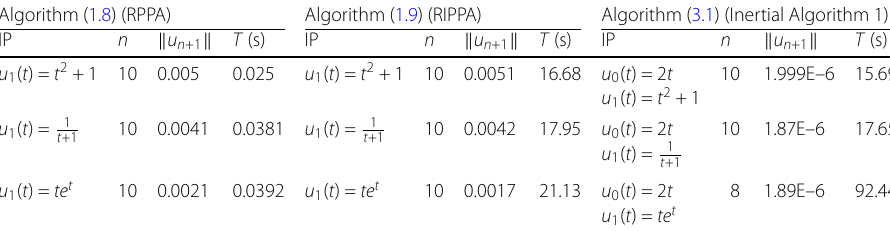
Table 2 Numerical results for Example